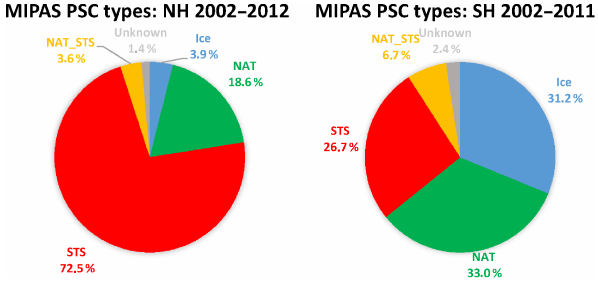
Figure 13. Breakdown of PSC types observed by MIPAS in the Arctic (December–March, left) and Antarctic (May–October, right) from 2002 to 2012. The percentages are averages over 10 and 9 sea- sons respectively, and relate to the total number of analysed spectra north/south of 55/ − 55 ◦ latitude. Spectra more than 6km below the actual CTH in the profile are not taken into account. In total 44622 cloudy spectra are analysed for the NH and 317699 for